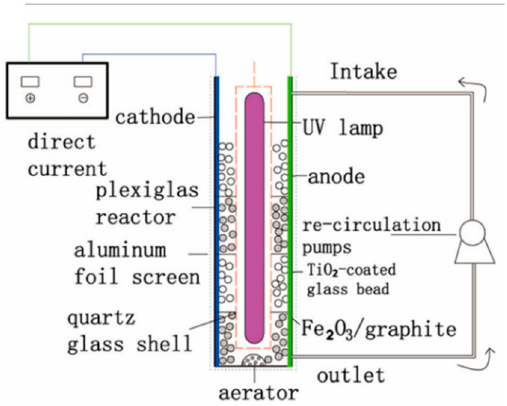
Figure 26. Schematic diagram of the three-dimensional electrode packed bed photocatalytic reactor. (Reproduced with permission from [106]: Liu, R.; Zhang, Y. Highly efficient degradation of berberine chloride form wastewater by a novel three-dimensional electrode photoelectrocatalytic system. Environ. Sci. Pollut. Res. 2018 , 25 , 9873–9886, doi:10.1007/s11356-018-1293-y. Copyright (2018), Springer Nature (Heidelberg, Germany)).